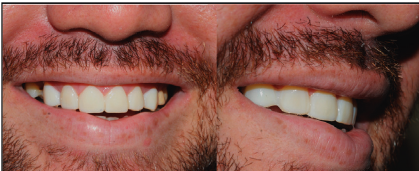
Figure 6: Result obtained with